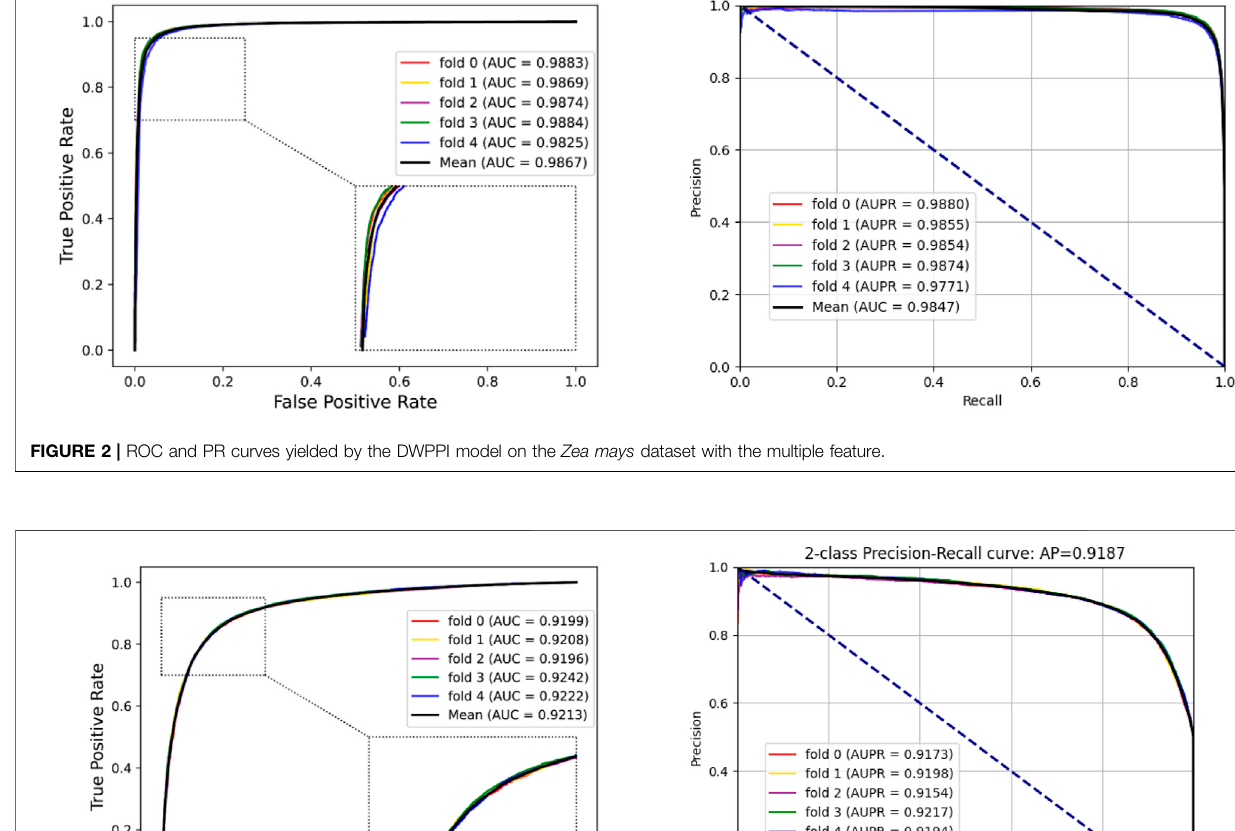
TABLE 4 | Comparison results of different classi fi ers in three model plant PPI datasets. Plant Classi fi er ACC. (%) Sen. (%) PR. (%) MCC.